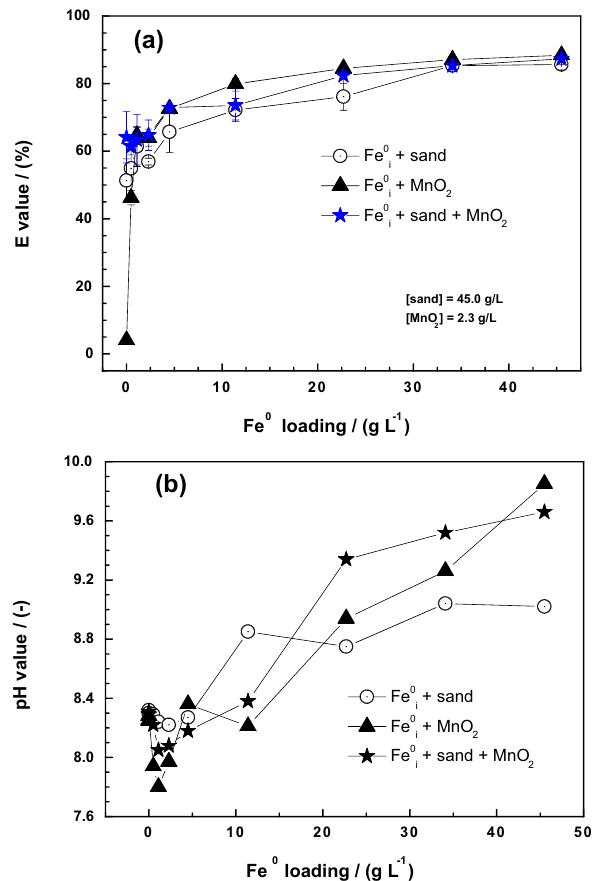
Figure 2. Changes in the Fe 0 , Fe 0 /sand, and Fe 0 /sand/MnO 2 systems as impacted by the addition of various Fe 0 loading for 47 days: ( a ) Methylene blue discoloration, and ( b ) pH value. Experimental conditions: [Fe 0 ] = 2.3 to 45 g L −1 ; [sand] = 22.5 g L −1 ; and [MnO 2 ] = 2.3 g L −1 . The lines are not fitting functions, they simply connect points to facilitate